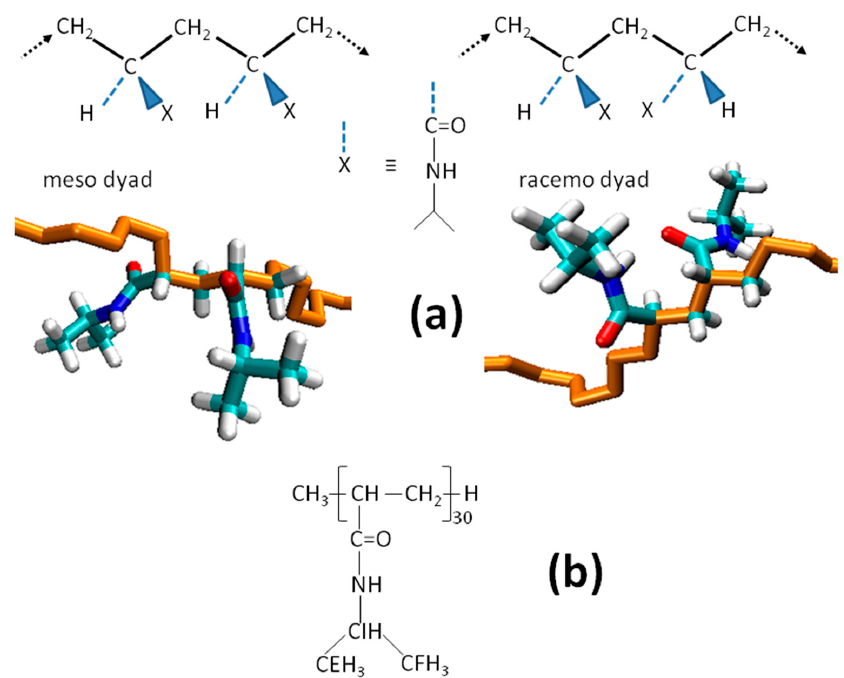
Figure 1. ( a ) Illustration of the meso and racemo dyads within the poly( N -Isopropylacrylamide) (PNIPAM) chain. ( b ) Chemical structure of the stereoisomers and nomenclature of side chain atoms. The time behaviour of the number of inter-chain contacts in the atactic and isotactic-rich PNIPAM solutions at 283 K is shown in Figure 2a. Polar and hydrophobic contacts are individually displayed.